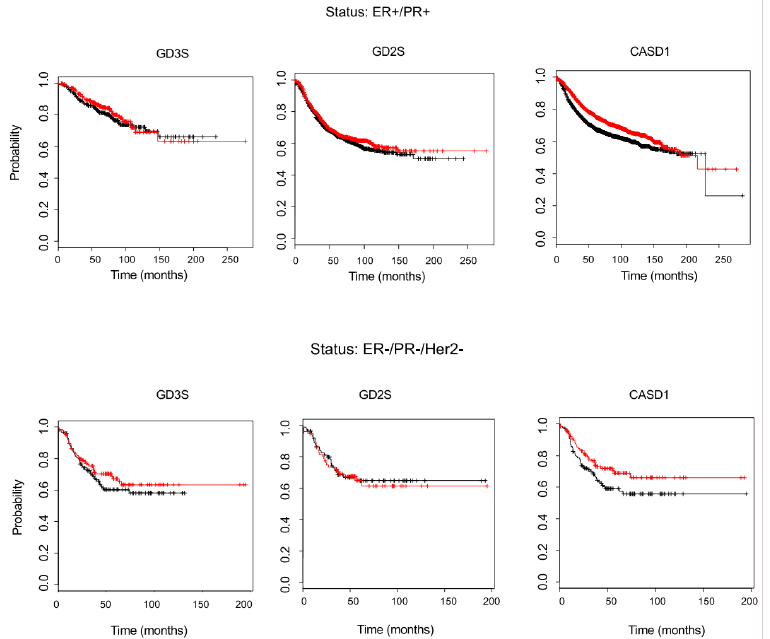
Figure 9. Kaplan–Meier survival plot in BC patients. The database integrates gene expression and clinical data simultaneously. The two patient cohorts are compared by a Kaplan–Meier survival plot, and the hazard ratio with 95% confidence intervals and log rank p value are calculated [31]. GD3 synthase, GD2 synthase, and CASD1 expression are assessed in ER+/PR+ BC patients ( upper ) and ER-/PR-/Her2- BC patients ( bottom ). The black line represents the overall survival of patient with a low gene expression. The red line represents the overall survival of BC patients with high gene